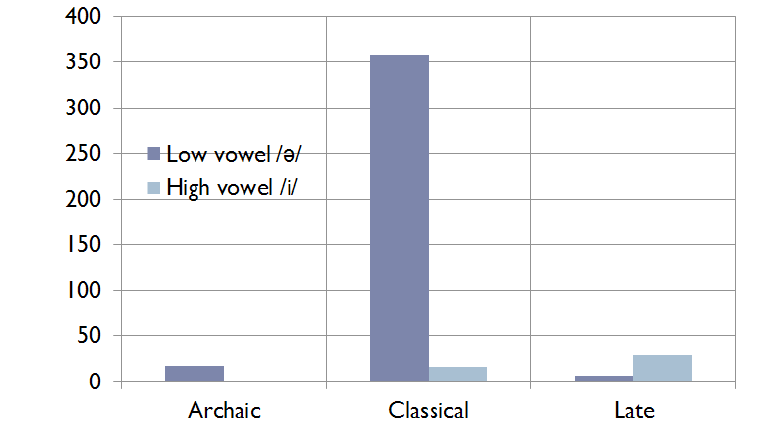
Figure 2: Attestations of other (selected) examples showing raised and non-raised variants (absolute numbers) The figures prove that the distribution of raised and non-raised forms of the pronoun on one hand and of other forms on the other hand is uneven. The raised variant ñiś of the pronoun is already much more common in classical texts than the non-raised variant ñǝś ; there is one attestation of ñiś found in the THT 3597 b 3, a text that is otherwise